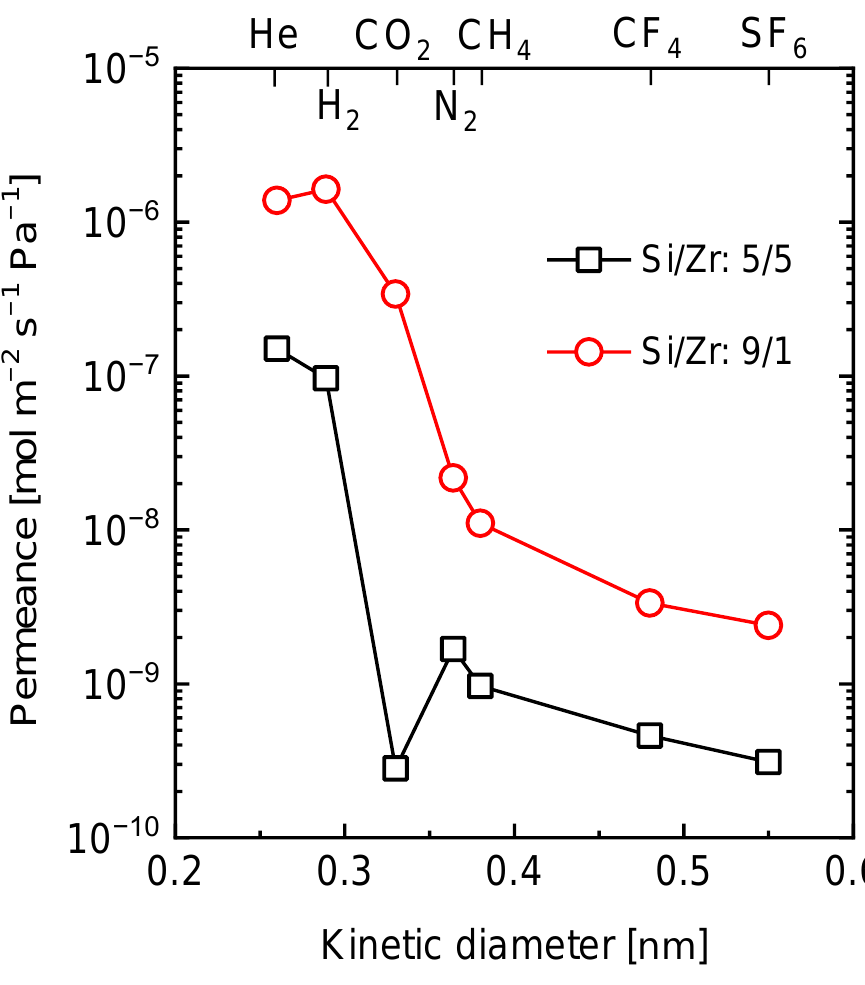
Figure 20. Single-gas permeance at 300 °C as a function of kinetic diameter for C-SiO 2 -ZrO 2 mem- branes (Si/Zr = 5/5 and 9/1). Adapted from [105,106].